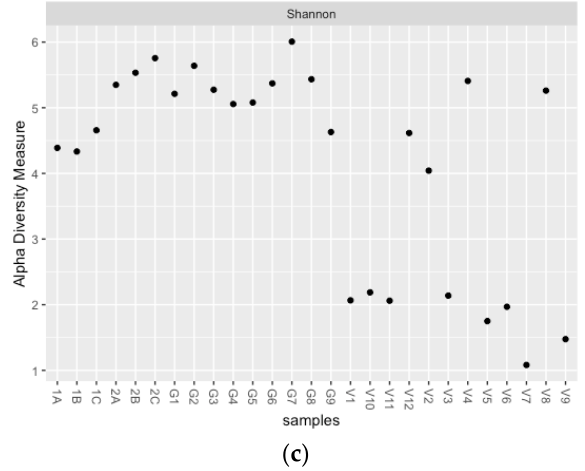
Figure 2. Actinobacterial species richness observed ( a ) and predicted ( b ) for the NR, GK, and VV samples, as well as the actinobacterial diversity (Shannon index; ( c )). NR = Nuwejaars River system